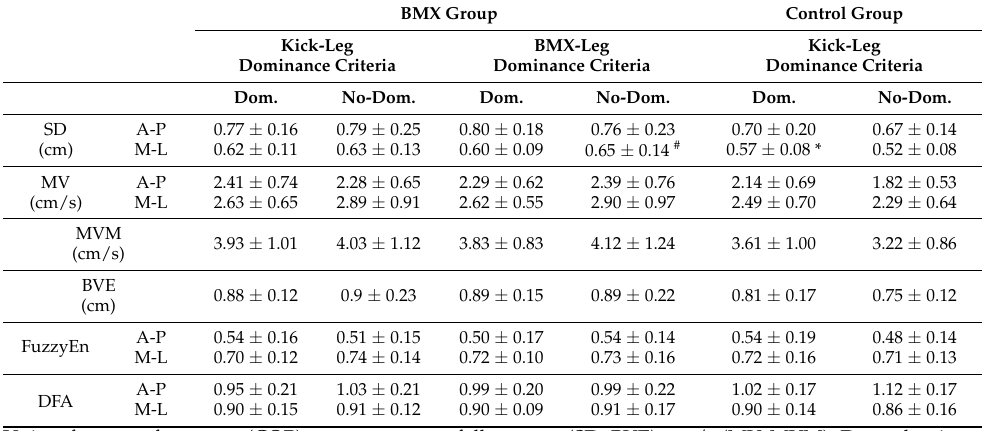
Table 2. Means and standard deviations of SD, MV, MVM, BVE, FuzzyEn and DFA, following the criteria of the preferred leg to kick a ball (Kick-Leg) and the forward leg to perform the skills on the bicycle